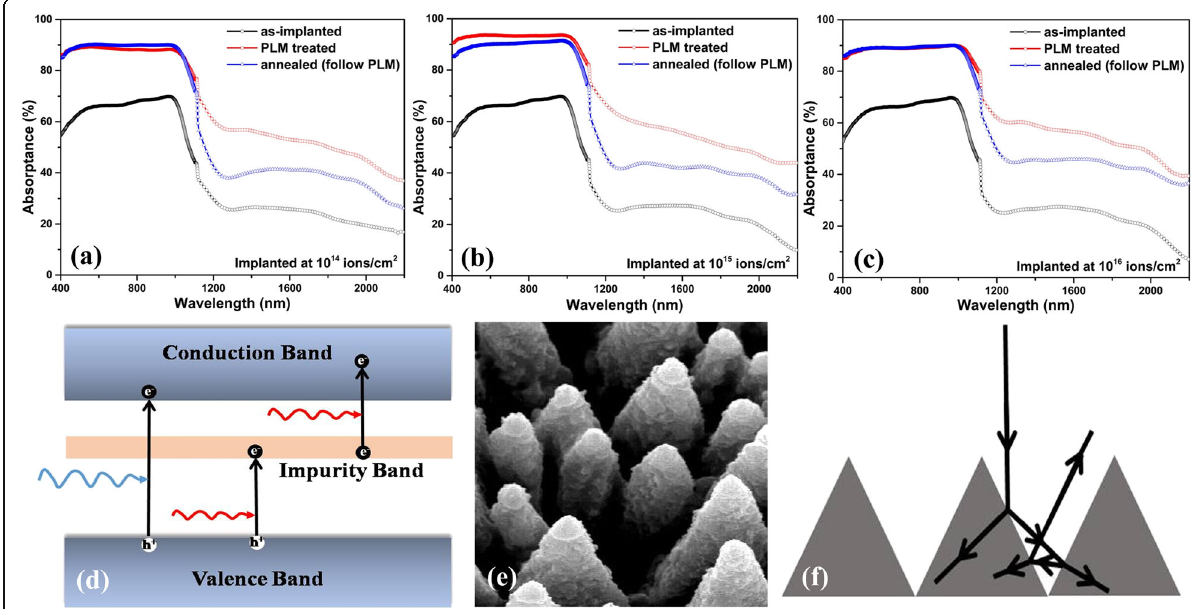
Fig. 1 a – c Dependence of absorptance on different fabrication process with various implantation doses. d Impurity band located within bandgap of Si facilitates generation of carriers which participate in absorption of lower energy photons. e Scanning electron micrograph of silicon spikes. f Illustration